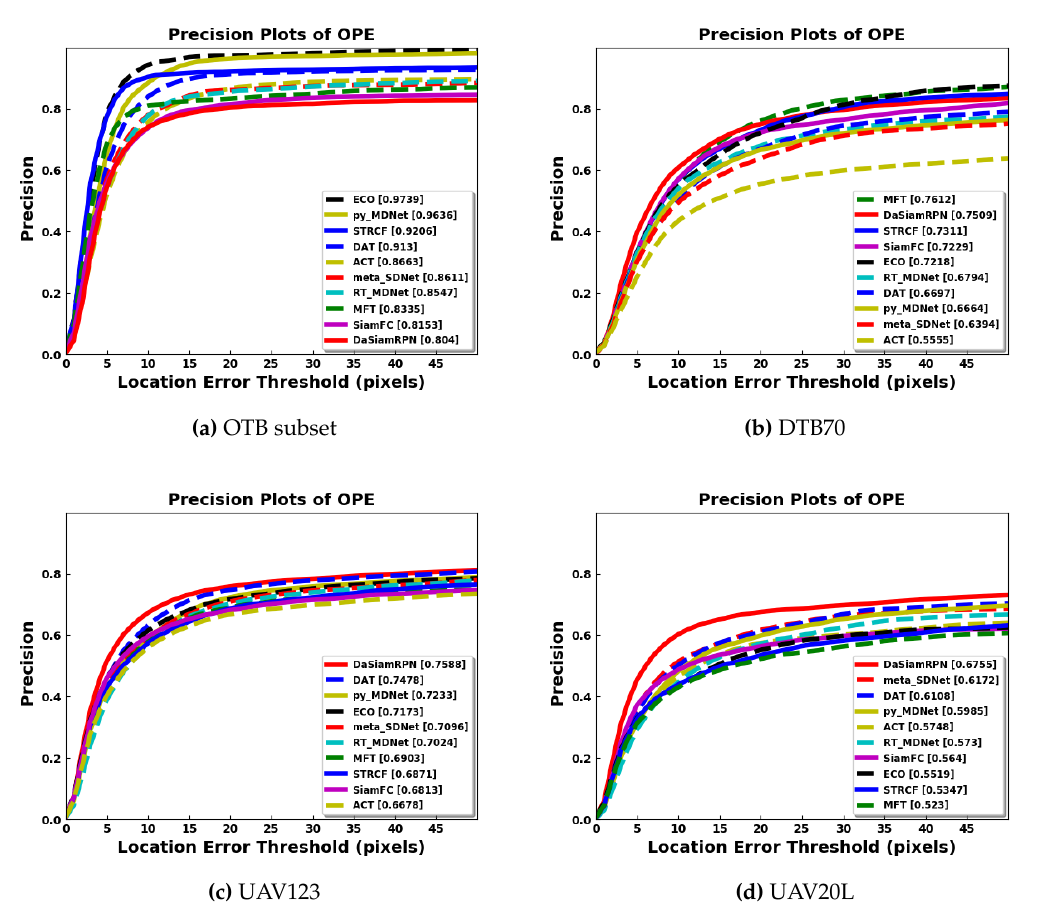
Figure 7. Precision plots of OPE. DaSiamRPN outperforms other trackers in UAV123 and UAV 20L datasets. ECO shows best performance for the OTB subset and MFT outperform other trackers in the DTB70 datset. Best viewed zoomed in and in color.